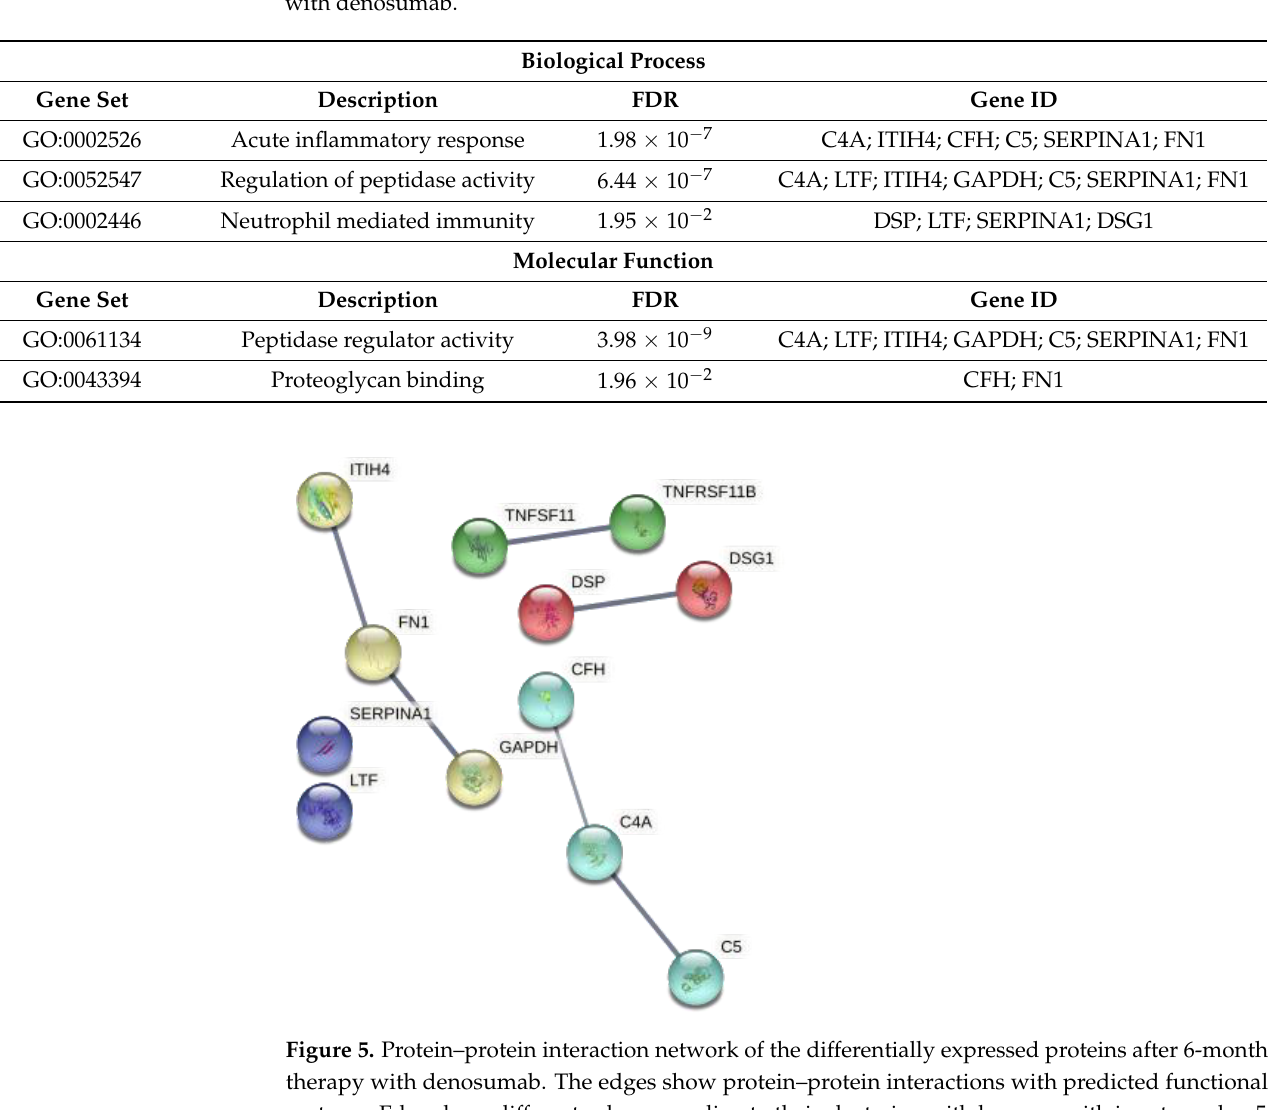
Figure 6. Gene-set enrichment analysis with the significant differentially expressed proteins after 6- month treatment with denosumab. Blue bars to the right are showing upregulating effects to the specific pathway. Light blue is not significant (FDR > 0.05), whereas dark blue is significant (FDR < 0.05).